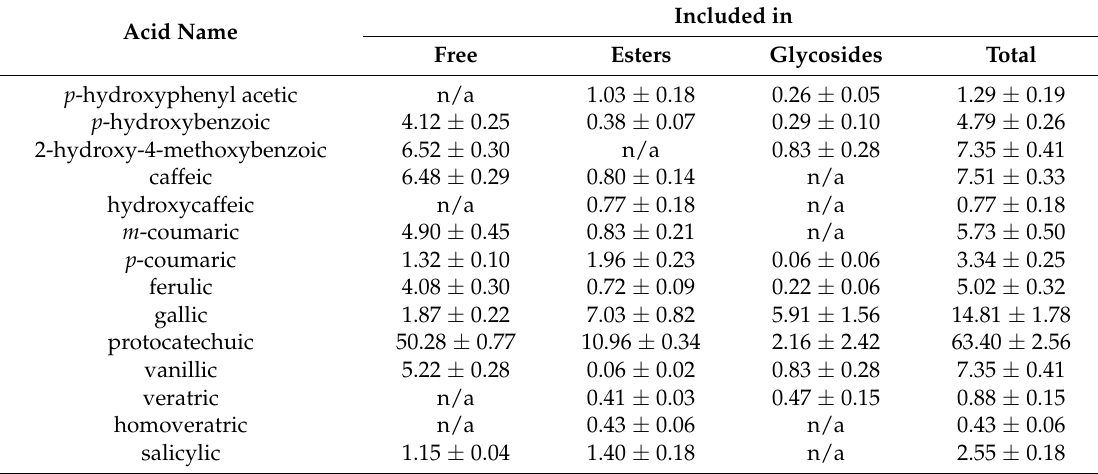
Table 2. Phenolic acid composition (mg/kg) in Oenothera biennis L. seed [9].